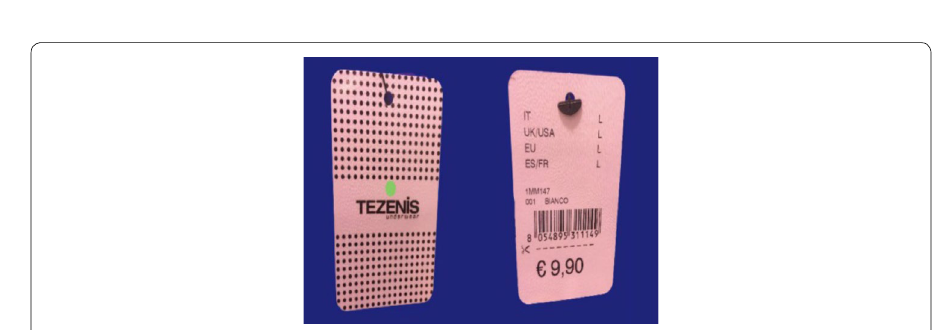
Fig. 22 Bershka label